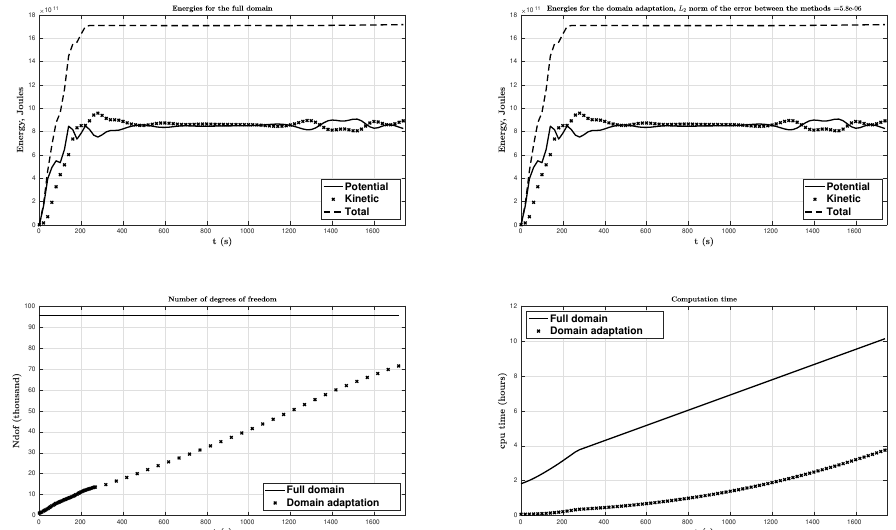
Figure 23. Active generation: comparison between the two methods (the full one and the domain adaptivity) of the kinetic, potential and total energies, the number of degrees of freedom, and the computation time of the simulation.